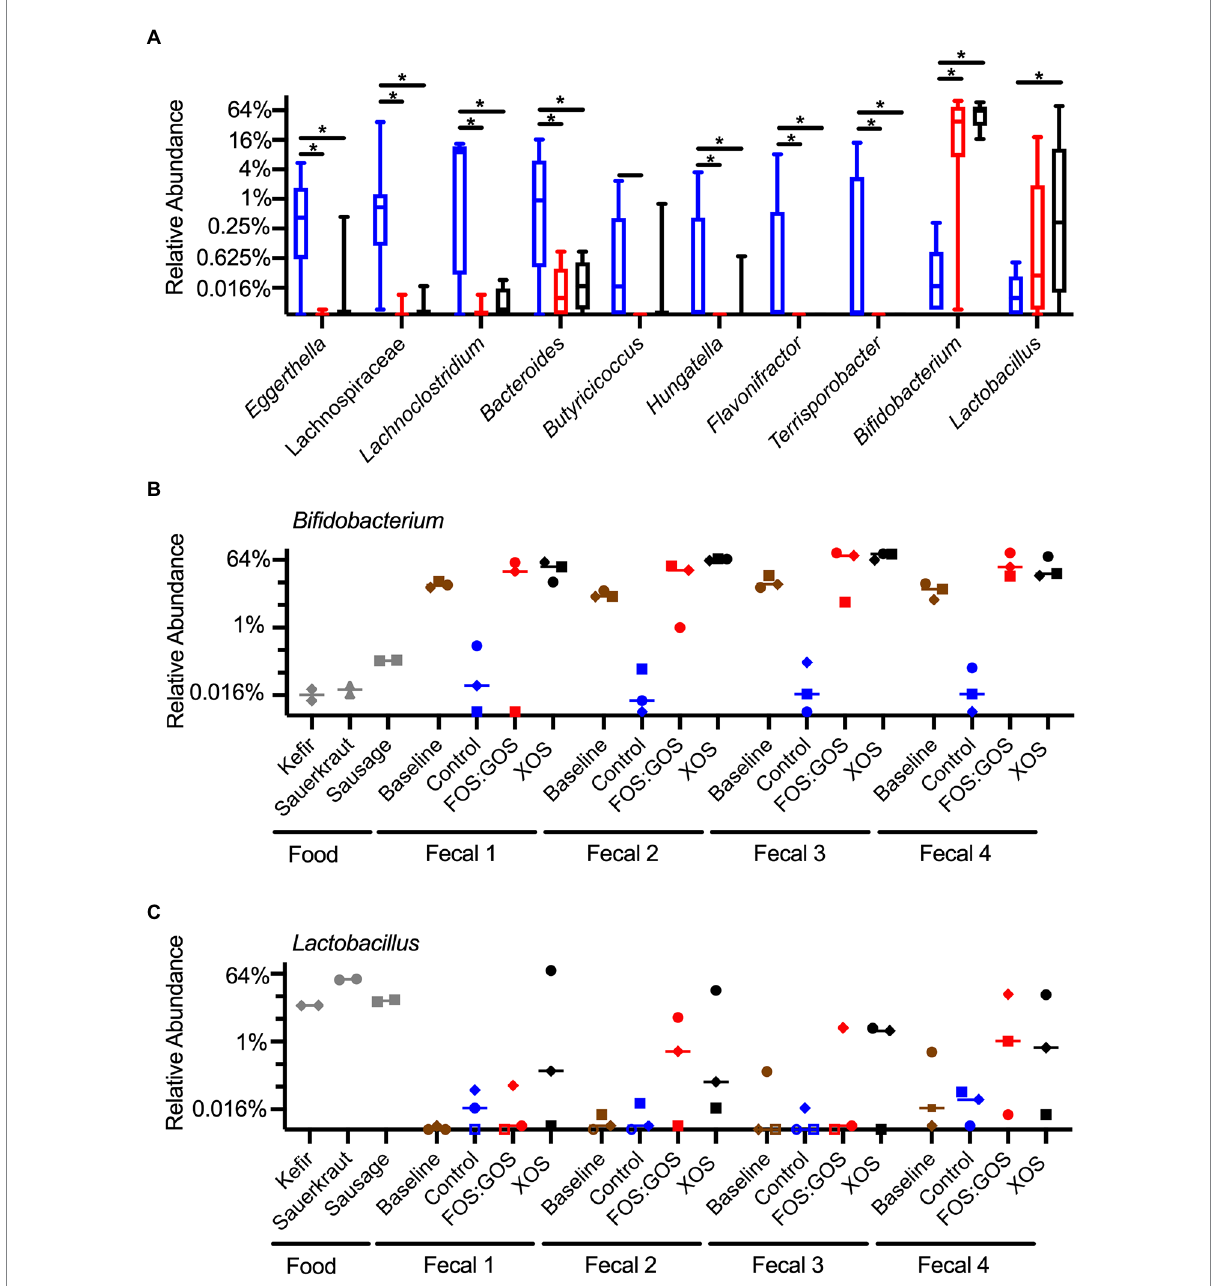
FIGURE 8 Prebiotic addition favors the enrichment of Bifidobacterium and Lactobacillus species. (A) Genera that differ significantly in abundance between control, FOS:GOS, and XOS-treated cultures after 96 h of in vitro culture. Boxes indicate the 25th–75th percentile, horizontal line indicates the median, and vertical whiskers indicate minimum and maximum values. All statistically significant comparisons are indicated by asterisks. (B) The relative abundance of Bididobacterium across each replicate sample is plotted with a horizontal line at the median value. (C) The relative abundance of Lactobacillus across each replicate sample is plotted with a horizontal line at the median value. In (B,C) , shapes of symbols indicated the fermented food added to each in vitro culture (kefir, diamonds; sauerkraut, circles; sausage, squares). In (A–C) , the baseline is set at the limits of detection. In (C) , open symbols indicate samples with sequences below the limit of detection, set at baseline for